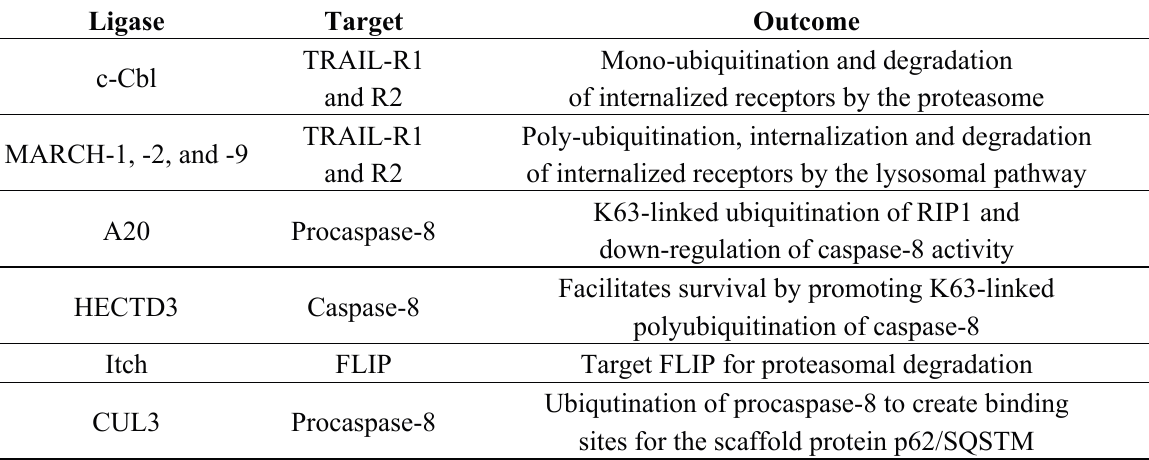
Table 1. Ubiquitin ligases and regulation of the TRAIL signaling pathway.